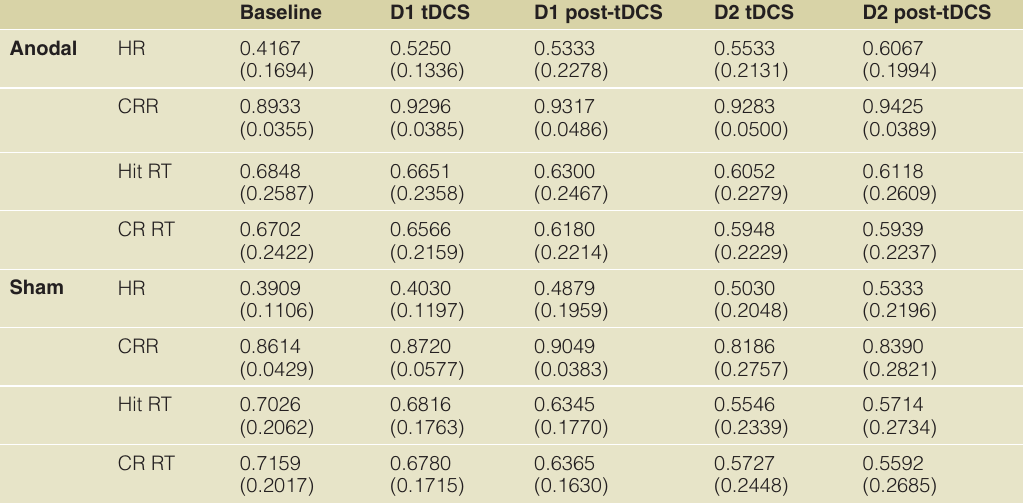
Table 1. Means and standard deviations of each 3-back session per group. D1 = day 1, HR = hit rate, CRR = correct rejection rate, RT = reaction time, CR = correct